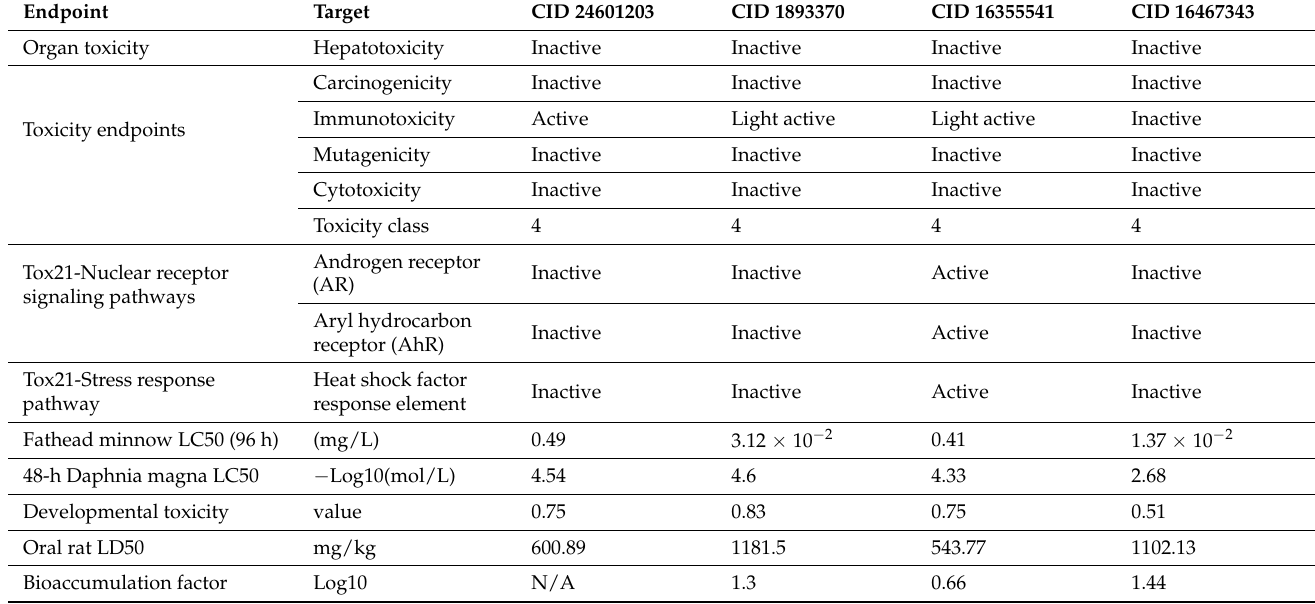
Table 5. List of toxicity properties (organ toxicity, toxicity endpoints, Tox21-Nuclear receptor signaling pathways, Tox21-Stress response pathway, Fathead minnow LC 50 (96 h), developmental toxicity, oral rat LD 50 , bioaccumulation factor) of the selected four